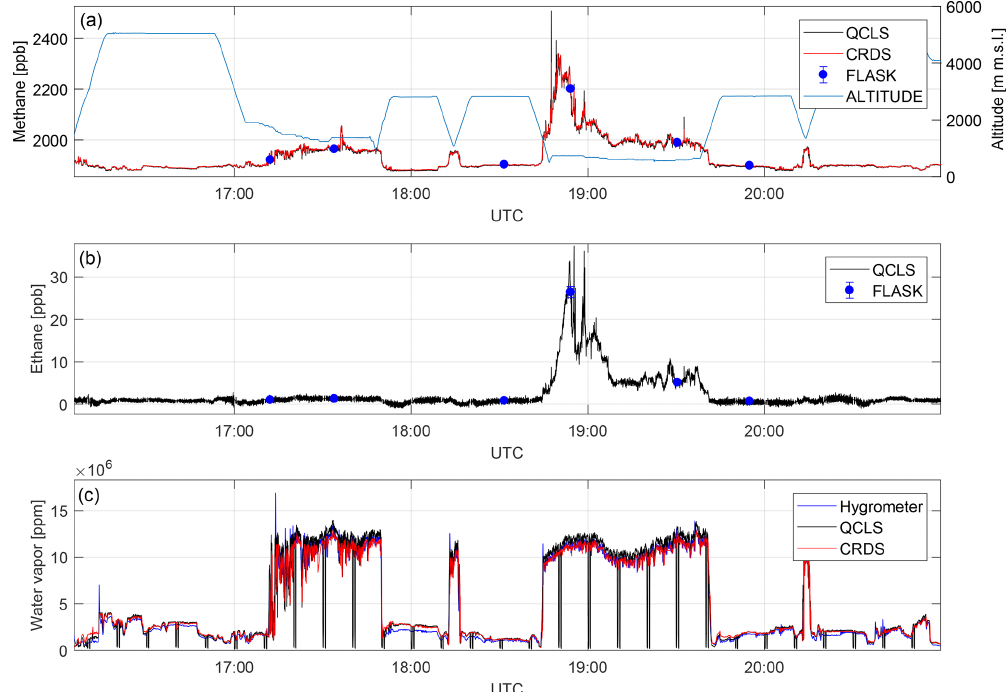
Figure 10. A direct comparison between dry-air mole fractions retrieved from different measurement techniques for a complete flight on 3 October 2017. Depicted are methane (a) , ethane (b) and water vapor (c) mole fractions. QCLS-retrieved methane data match with CRDS and flask data to within 1.4ppb (1 σ ) and 3.9ppb (1 σ ), respectively, after correcting for a constant bias. QCLS-retrieved ethane data agree with flask data to within 0.4ppb (1 σ ). Water vapor sensed by an onboard dew-point hygrometer does differ from the CRDS and QCLS data. Table 3. Typical in-flight performance including contributions to overall uncertainty. The total measurement uncertainty at 1s temporal res- olution is given by the quadrature sum of the individual contributors. Due to the lack of appropriate NOAA standards during the deployment, the uncertainties in C 2 H 6 , CO and N 2 O include combined uncertainties from concurrently measuring instruments (CRDS and FLASKS). The total uncertainties stated for these species do therefore not reflect the intrinsic uncertainties of the instrument, but rather worst-case val- ues, that may have been better given the availability of appropriate standards. The WMO compatibility goals for Global Atmosphere Watch network compatibility among laboratories and central facilities have been added for